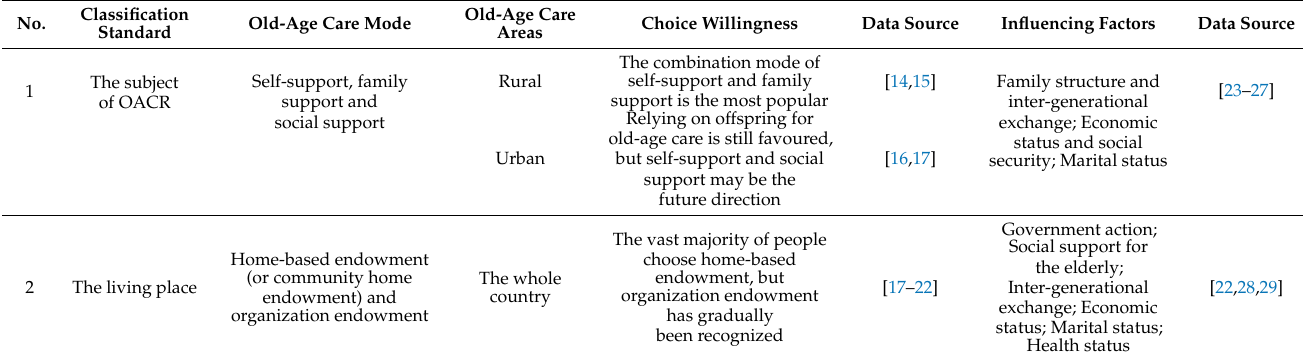
Table 1. Willingness to Choose Old-Age Care Mode and Its Influencing